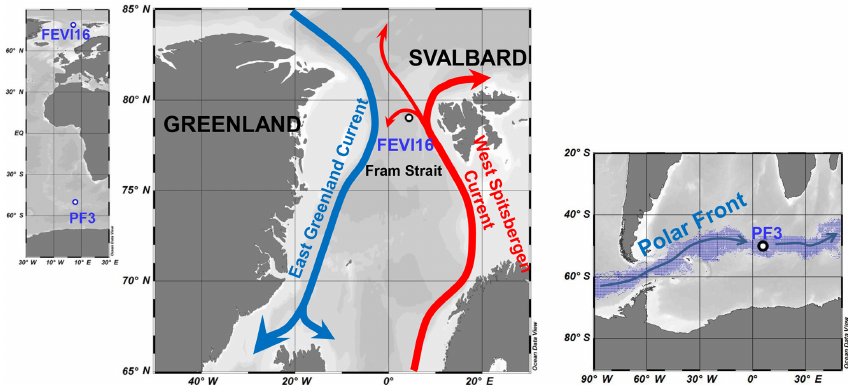
Figure 2. Map of sediment trap locations in high northern latitudes (FEVI16) and in Antarctic Polar Front (PF3). In the Fram Strait, the northward red arrow represents the West Spitsbergen Current bringing warm and saline Atlantic waters to the Arctic and the southward blue arrow displays the East Greenland Current transporting cold and fresh water to the Norwegian Sea. Around the Antarctic, the digitized blue shadow exhibits the location of the Antarctic Polar Front for the years 2002–2014 at weekly resolution (Freeman and Lovenduski, 2016). The blue arrow indicates the clockwise Antarctic Circumpolar Current. Ocean Data View is used for mapping (Schlitzer, 2017; available at https://odv.awi.de, last access: 3 May